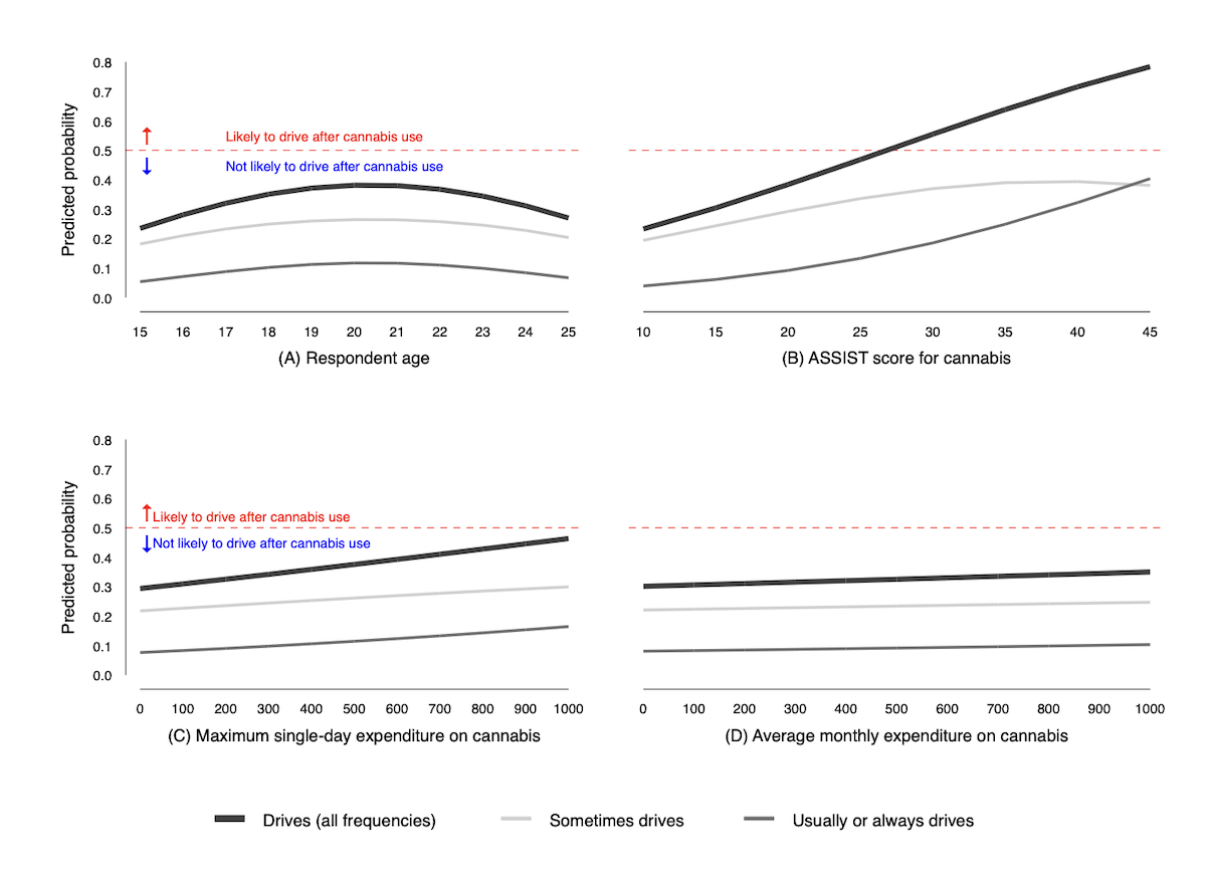
Figure 5. Probability of driving after cannabis use is low over a range of respondent characteristics (n=913). ASSIST: Alcohol, Smoking, and Substance Involvement Screening